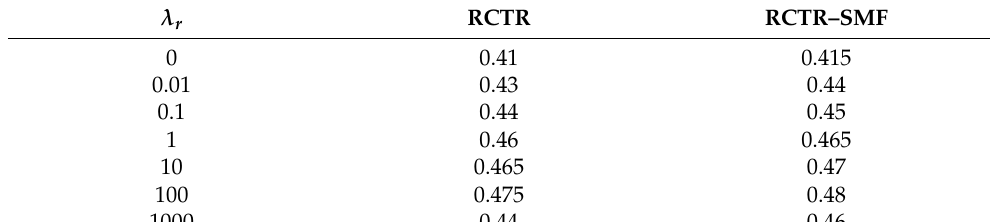
Table 6. Recall Comparison of RCTR and RCTR–SMF.